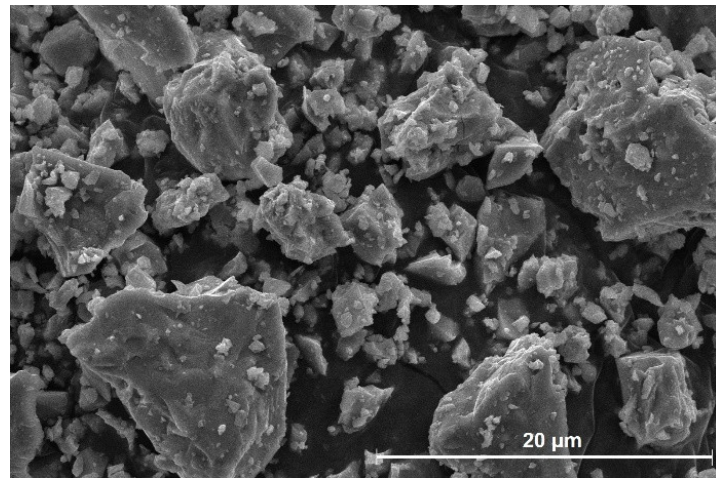
Figure 3. SEM micrograph of CSA cement.